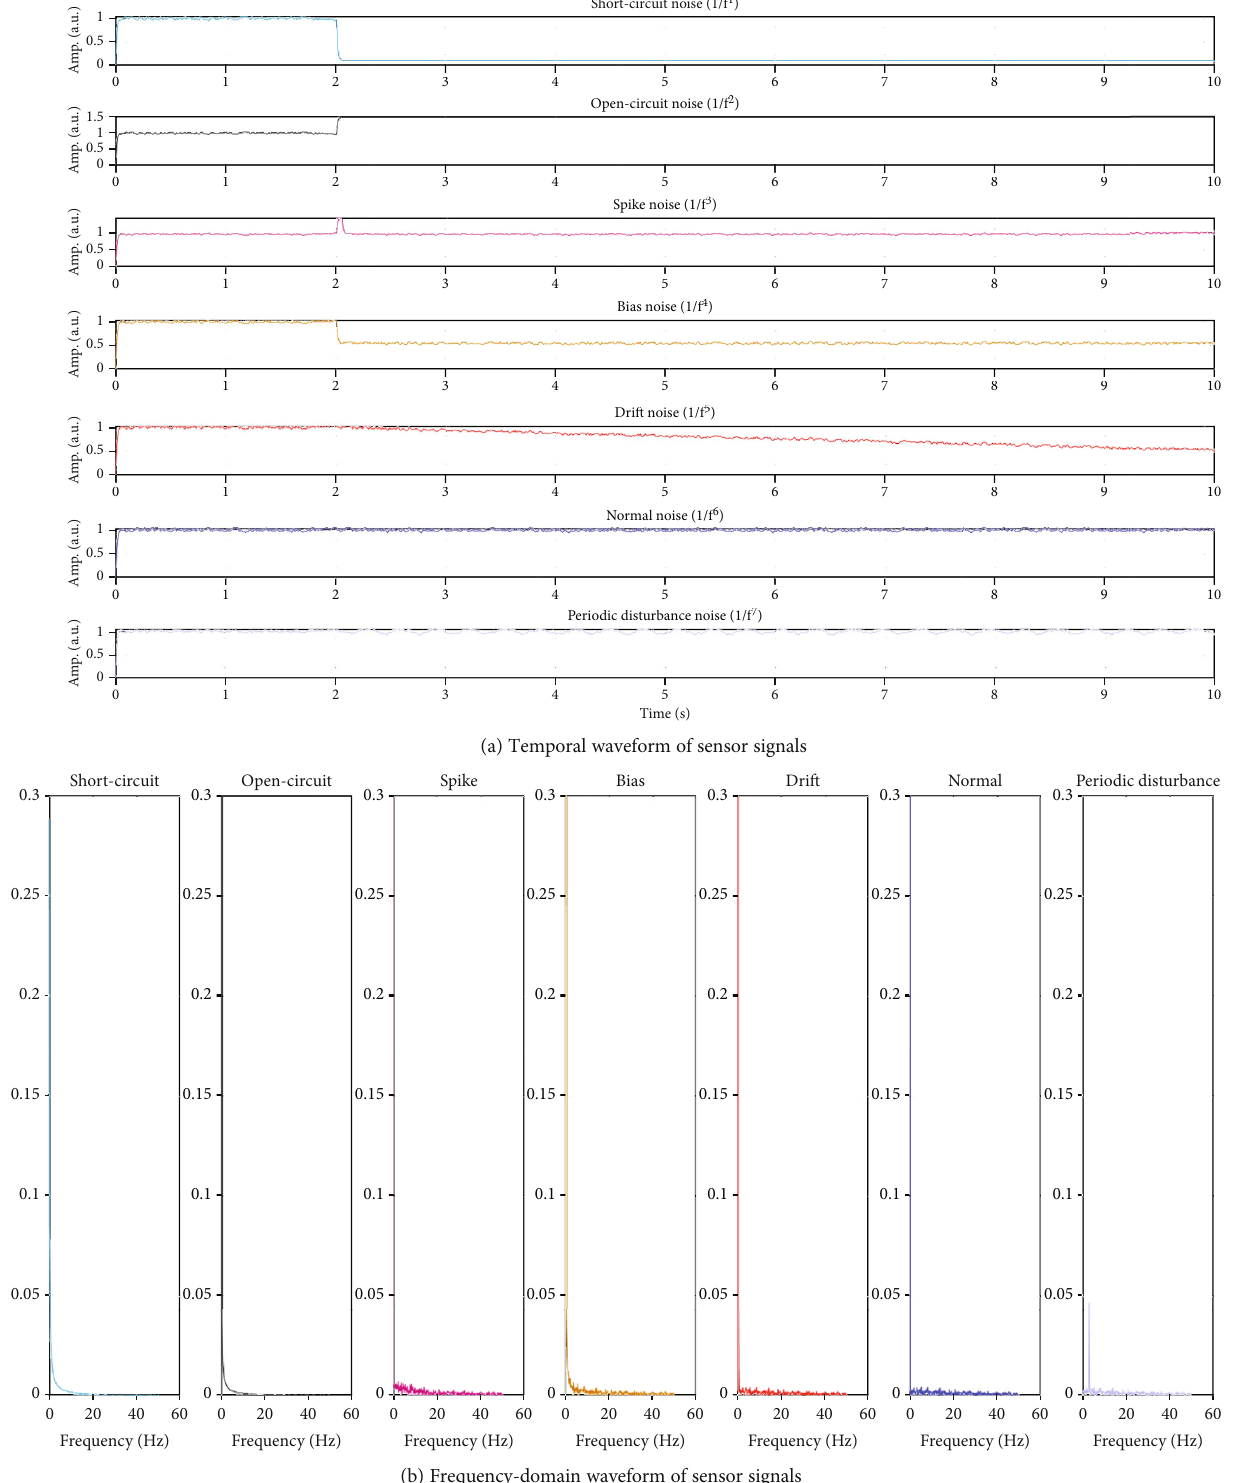
Figure 11: Simulated sensor signals for 7 health